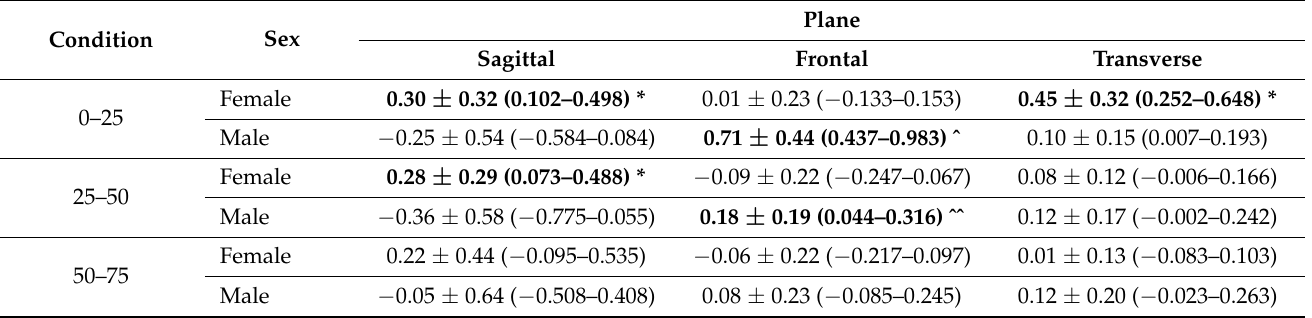
Table 1. Limb support moments (sex comparison) initial contact.